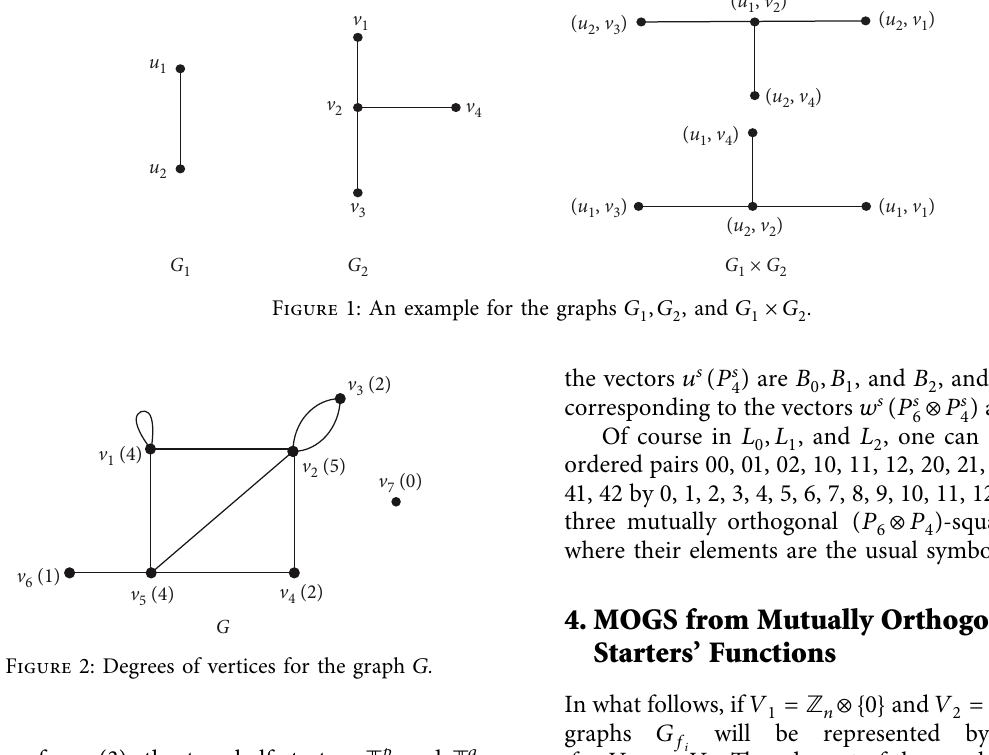
Figure 1: An example for the graphs G